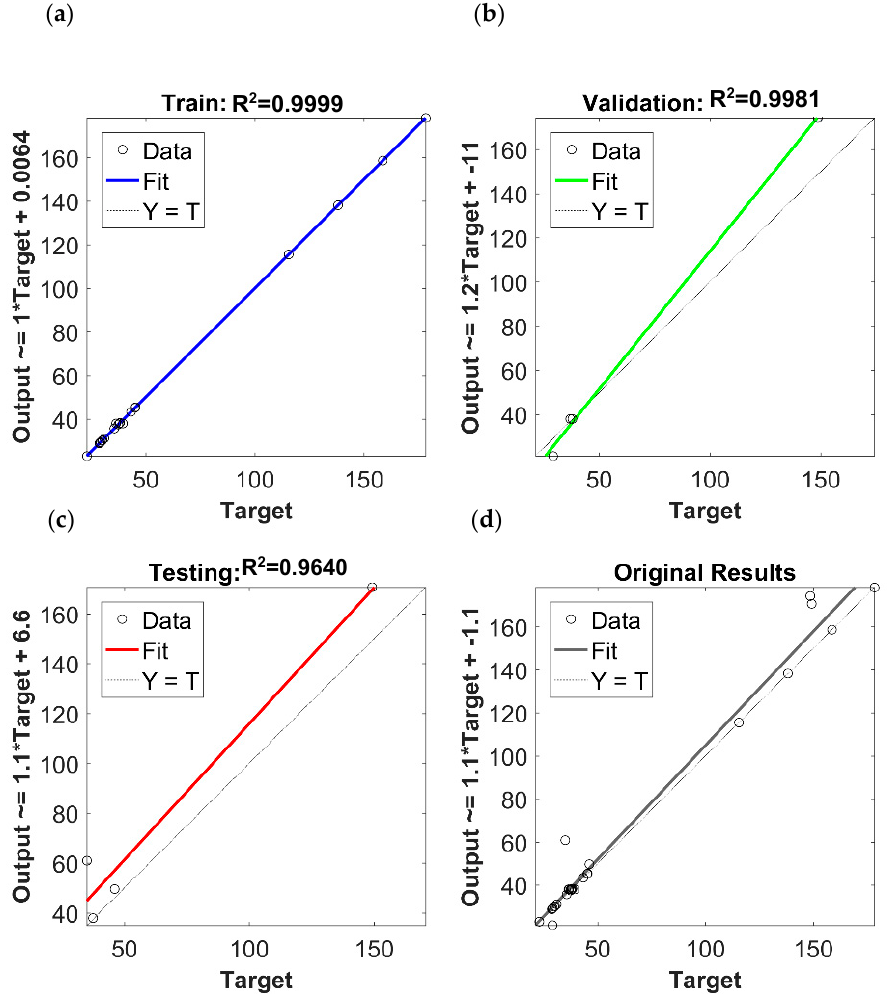
Figure 6. The scatter plots of ANN model predicted values (permeate flux) versus experimental values for ( a ) training, ( b ) validation, ( c ) testing, and ( d ) all data sets.